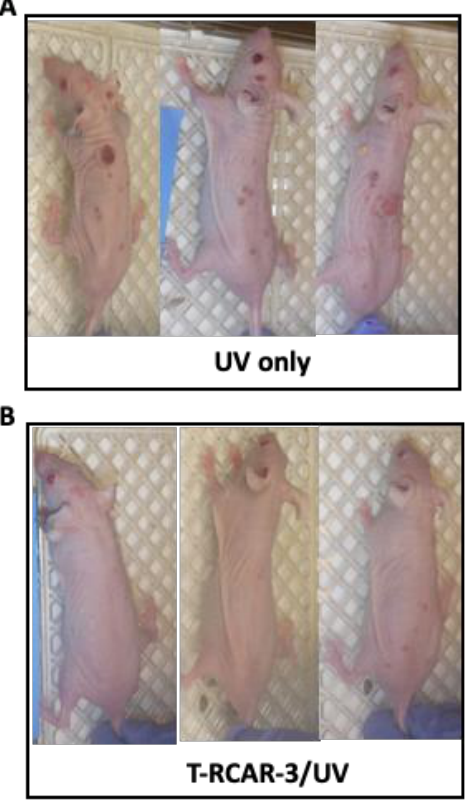
Figure 8. Effects of T-RCAR-3 on UV-induced tumor formation in SKH-1 mice. Mice were pre-treated with T-RCAR-3 for two weeks and were exposed to gradual doses of UV up to 150 mJ/cm 2 three times per week; T-RCAR-3 treatments were given immediately after each irradiation. Representative photographs of mice from the UV-treated and UV-treated plus T-RCAR-3 at week 20 are shown. ( A ) Mice that were exposed to UV, without drug treatment. ( B ) Mice that were treated by T-RCAR-3 and exposed to